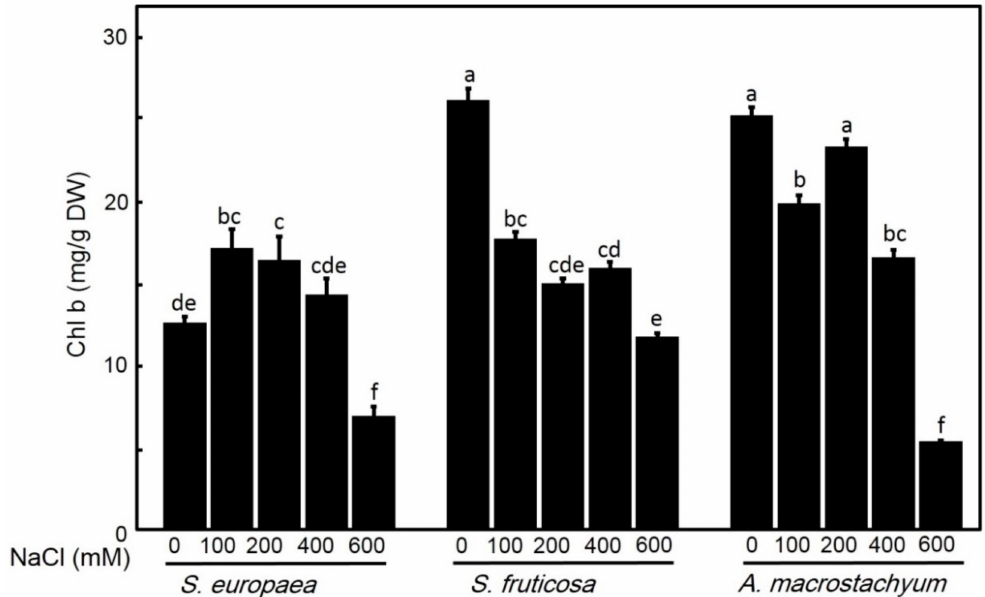
Figure 6. Chlorophyll b contents of S. europaea, S. fruticosa and A. macrostachyum under different NaCl concentrations. Mean ± SE of three replicates. Different letters indicate significant differences ( p <